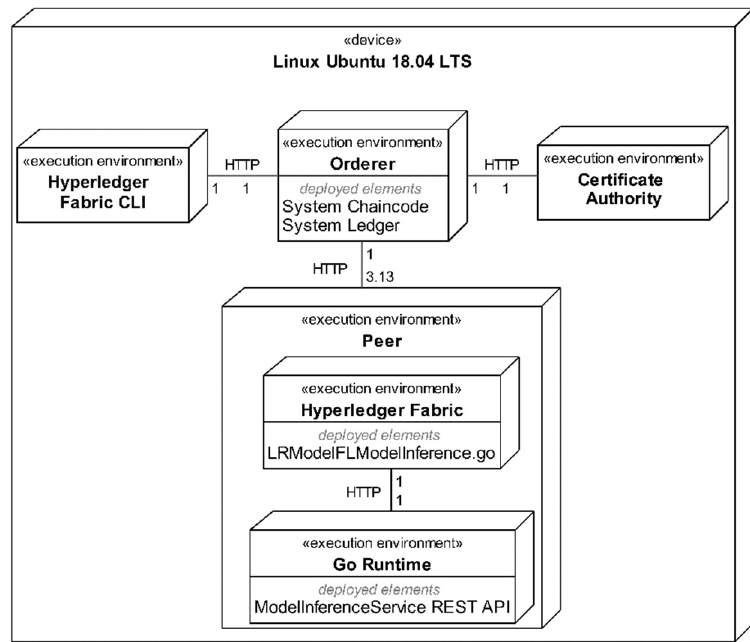
Figure 7. Physical view of the utilized blockchain architecture: UML deployment diagram. All components were hosted on the same physical server, using Docker [36] containers.